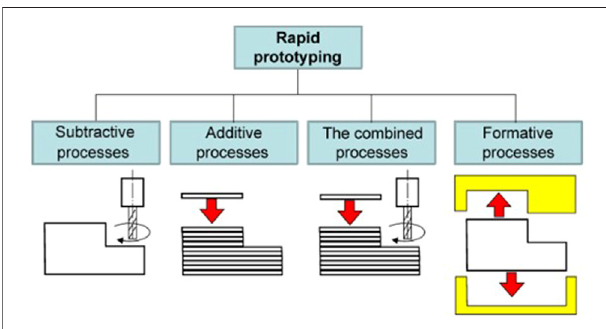
FIGURE 6 | Fundamental classi fi cation of RPM. Image was adapted from Zivanovic et al. (2020) under the Creative Commons Attribution